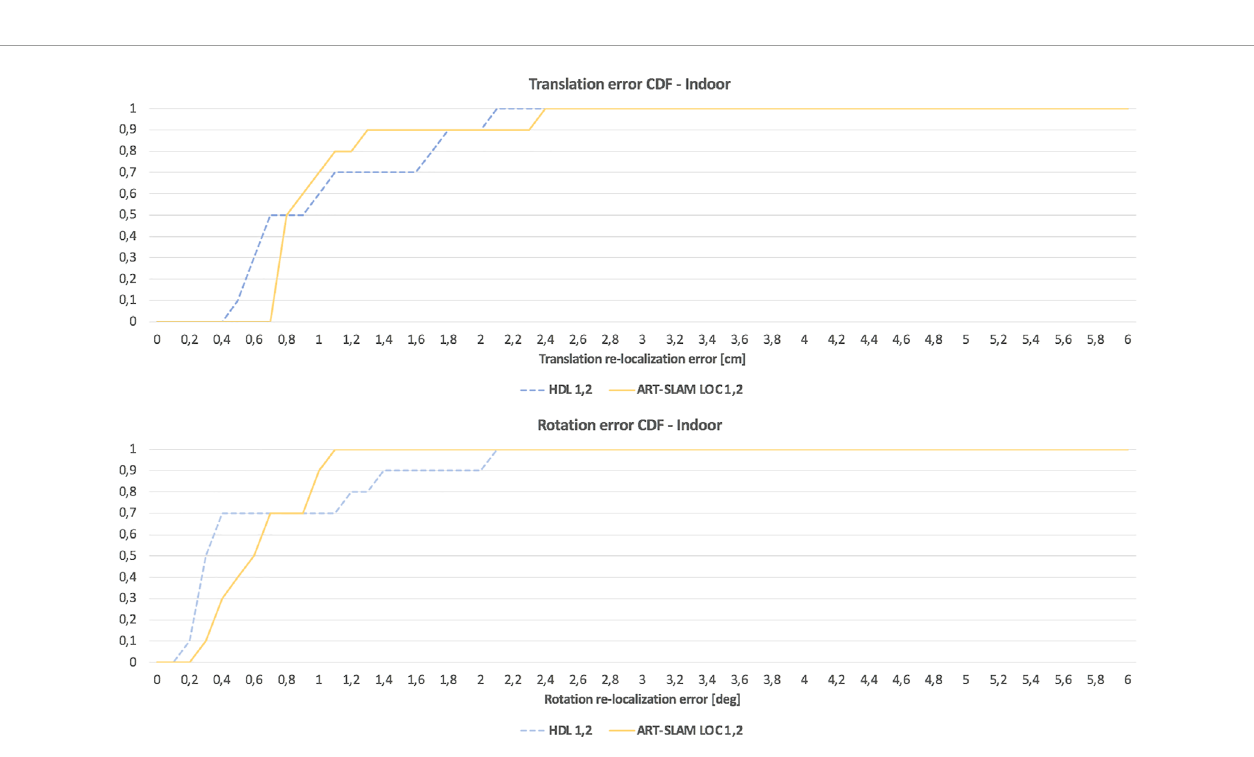
1 M points, while the number of acquired points sums up to 404